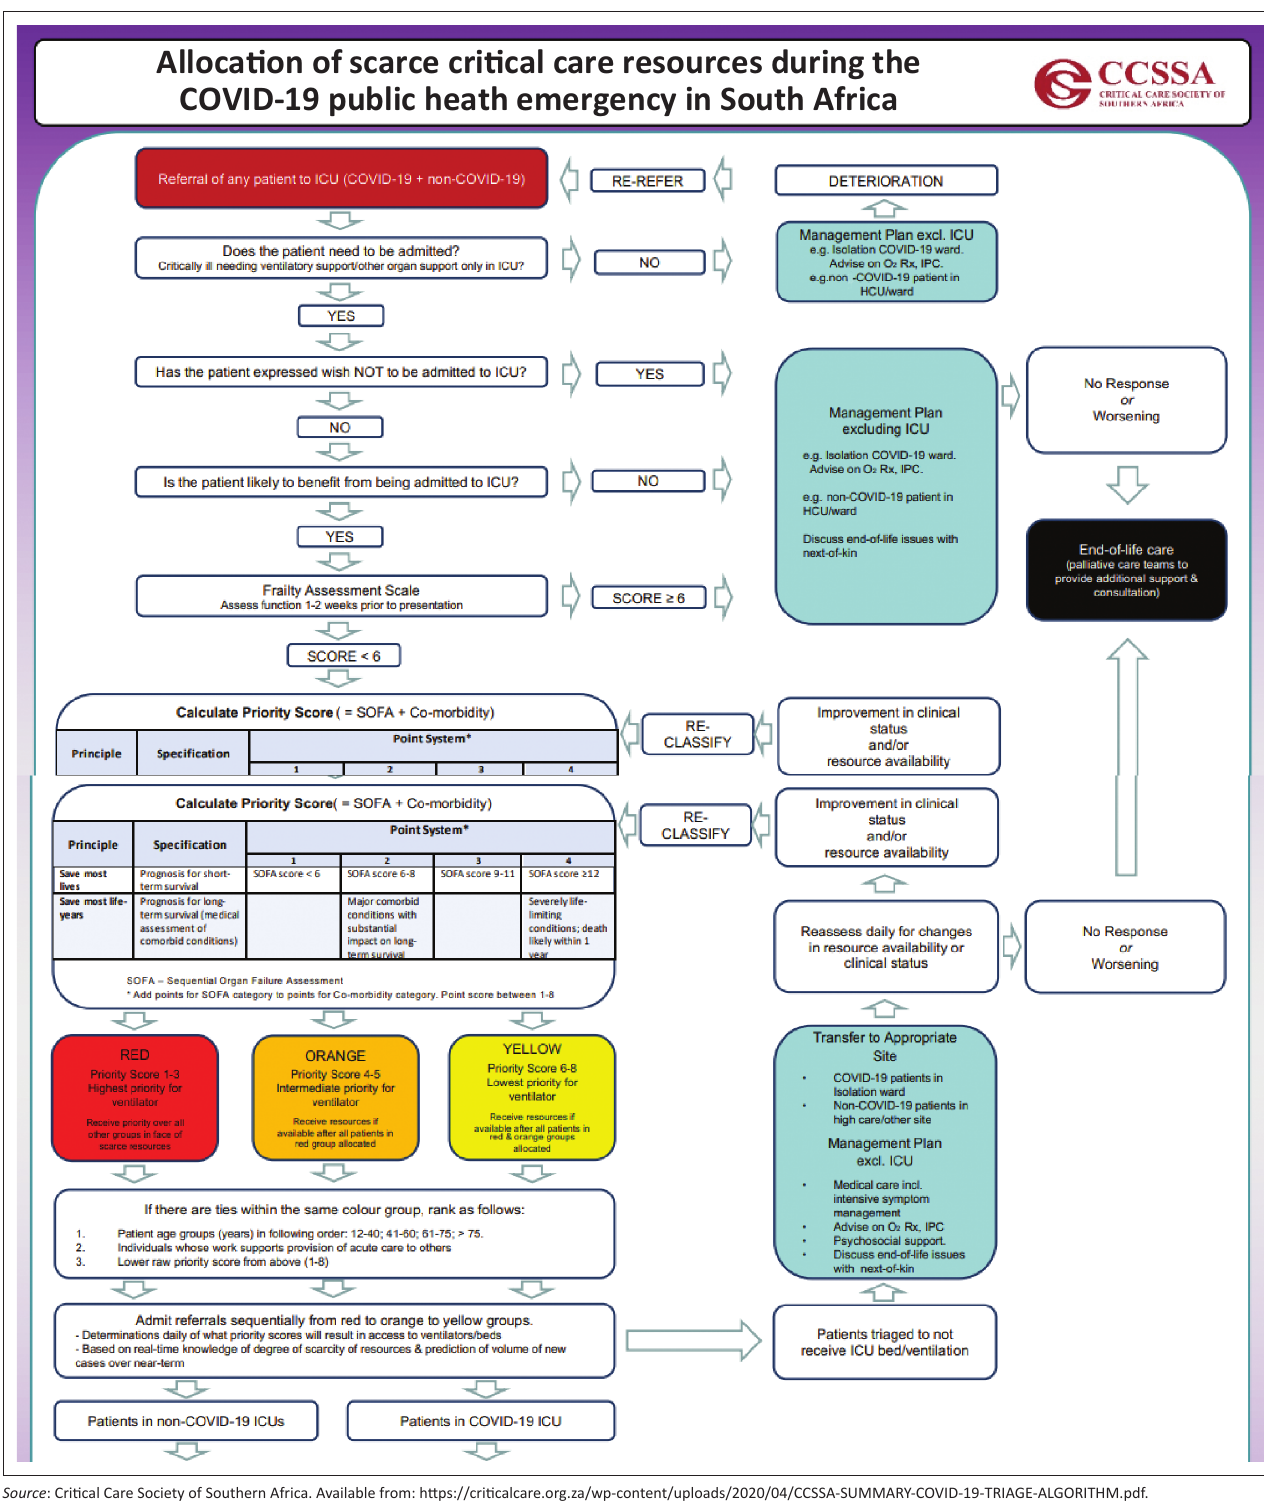
FIGURE 1: Excerpt of algorithm: Allocation of scarce critical care resources during the COVID-19 public health emergency in South Africa.